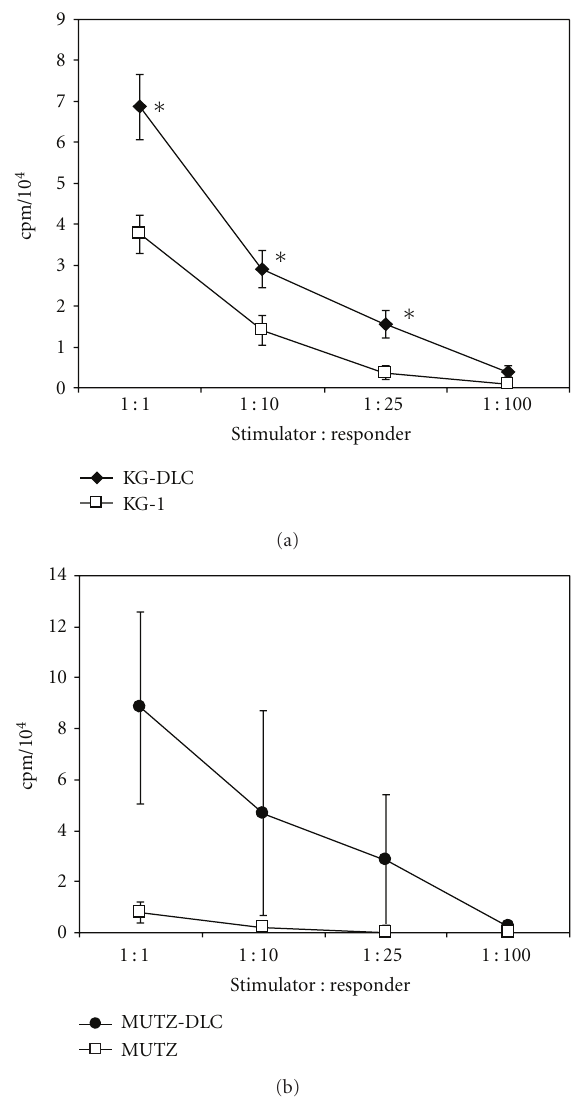
Figure 5: 3 H-thymidine incorporation in MLC of DLC generated from KG-1 and MUTZ-3 cells. The MLC measurement was carried out after coculture with KG-1 (a) and MUTZ-3 (b) to check the donor PBMC proliferation. DLC were obtained from either KG-1 cells (KG-DLC) using FastDC culture or MUTZ-3 cells (MUTZ- DLC) using 7-day culture, and the proliferation stimulated by DLC was compared with that of normal KG-1 or MUTZ-3 cells. Results are expressed as mean ± SEM, n = 3 for using PBMC collected from three donors. ∗ P < 0 . 05 compared with